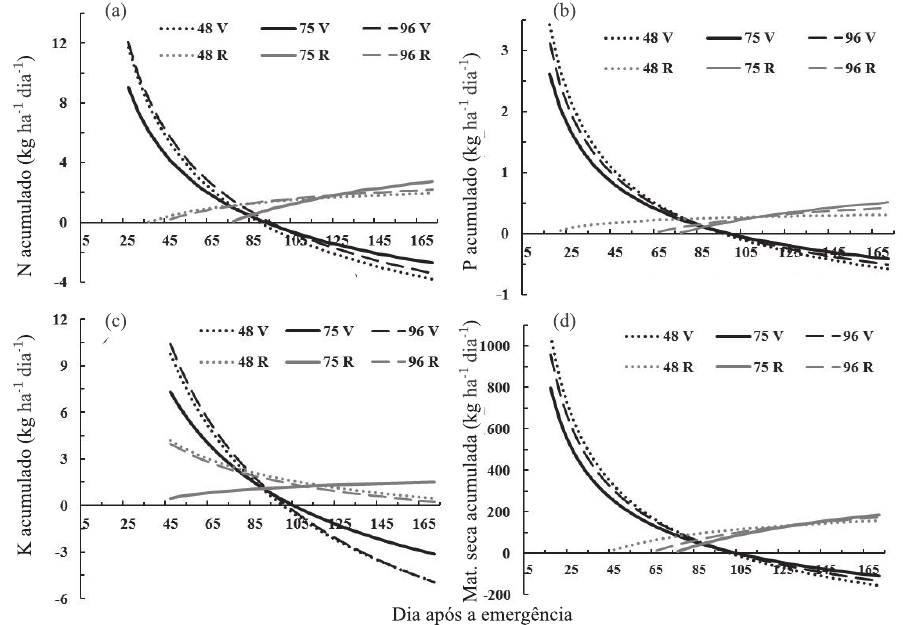
figura 5. taxa de acumulação diária de N (a), p (b), K (c) e matéria seca (d) nas partes vegetativas (v) e reprodutivas (r) do algodoeiro cultivado nos espaçamentos de 48, 75 e 96